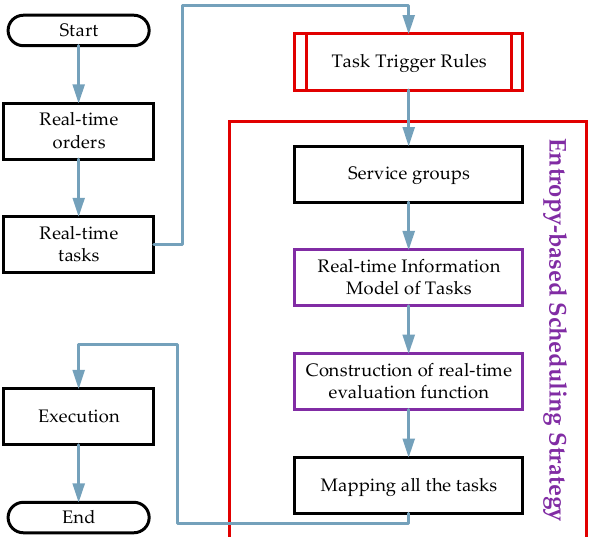
Figure 2. The flowchart of production and logistics resources (PLRs) adaptive scheduling.